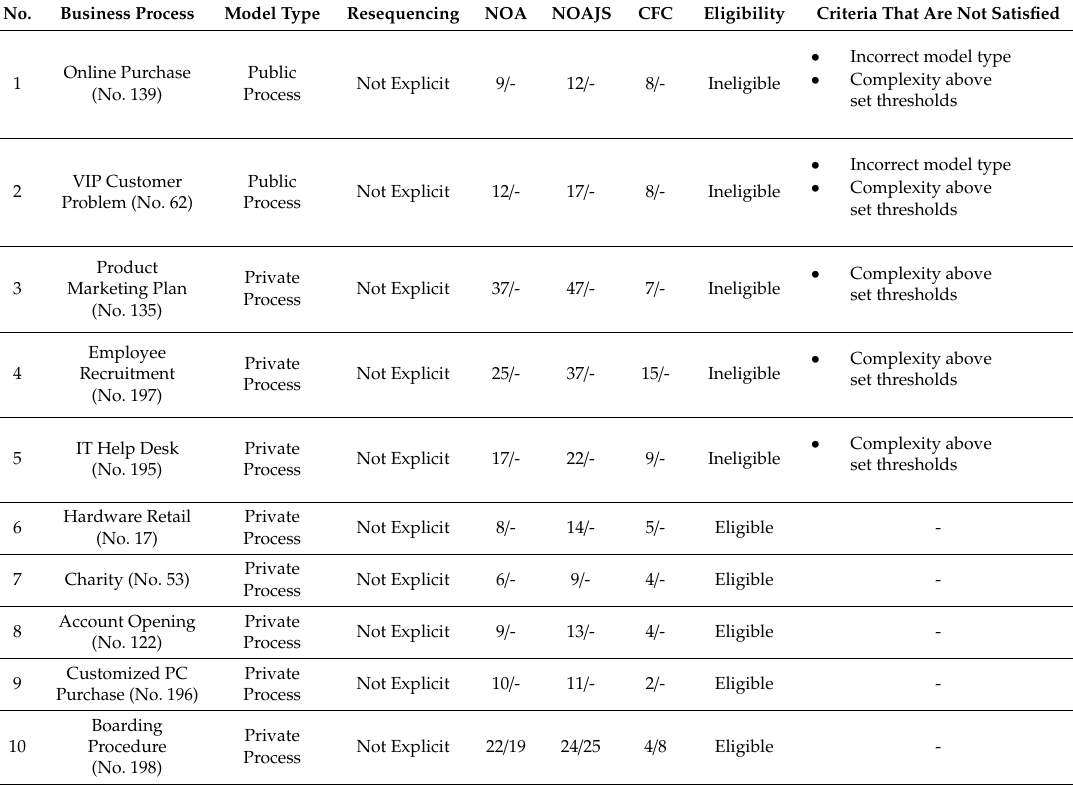
Table 1. BPMN examples from the SOA-based business process database